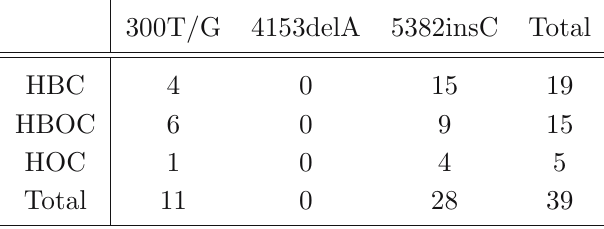
Table 2 Detailed distribution of BRCA1 mutations in patients with definitive FBC.